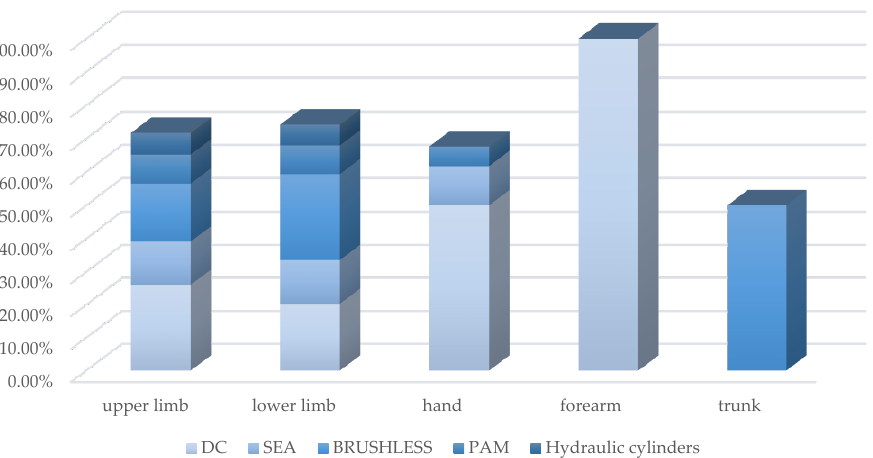
Figure 20. The distribution of the most used actuator types for exoskeletons dedicated to the different anatomical districts. Brushed DC motors are dominant for hand exoskeletons (50%), have percentages of 26% in ULE and 21% in HED (Hand Exoskeletal Device). Brushless DCs are dominant in LLE (26%), are present with the 17% in ULE and are not present in HED. PAMs have percentages of 8%, 8% and 6% for ULE, LLE and HED,